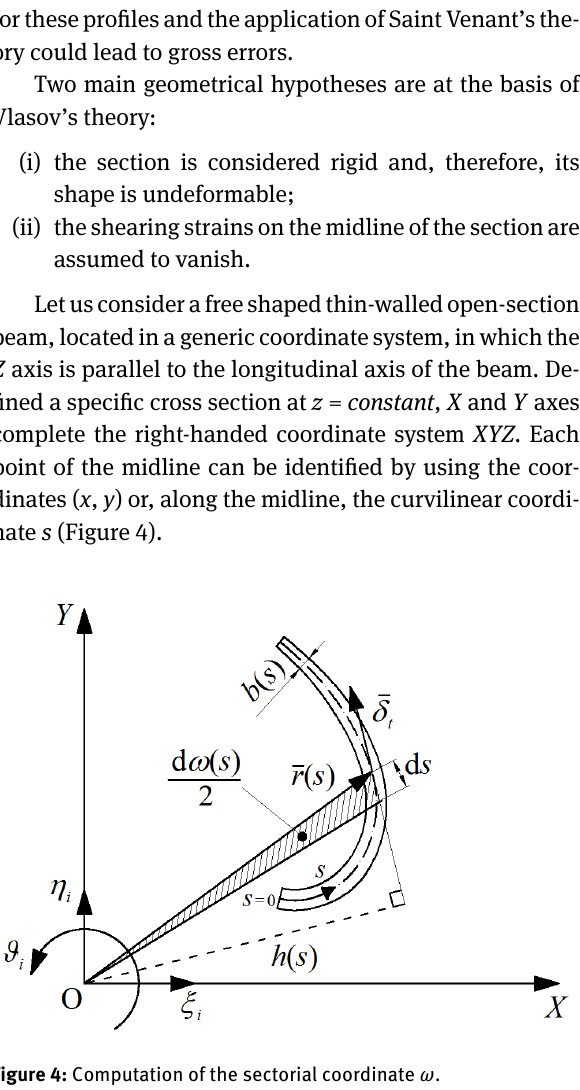
Figure 4: Computation of the sectorial coordinate ω